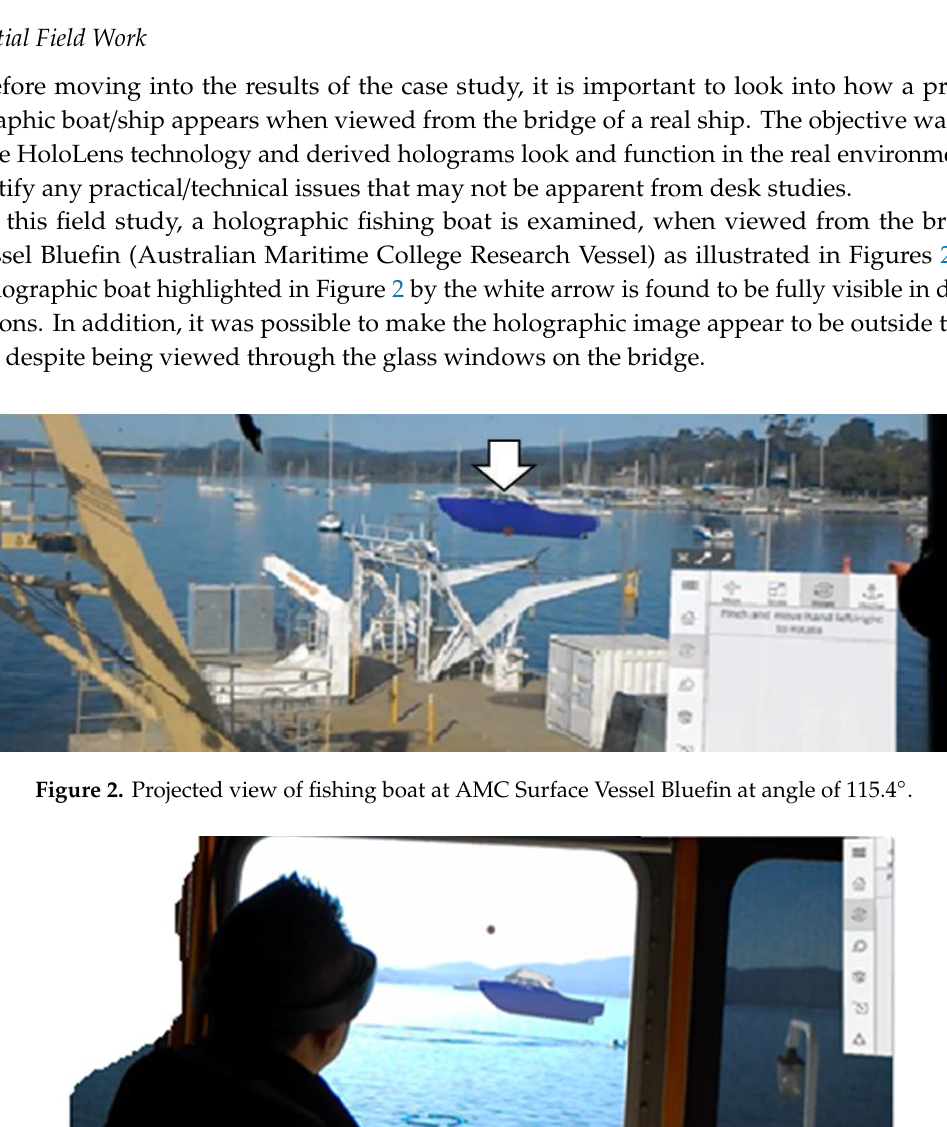
( c ) Figure 5. Matching spheres of different colors (size and luminosity) with the actual light at a distance of 150 m. ( a ) Red color spheres; ( b ) blue color spheres; ( c ) green color spheres.